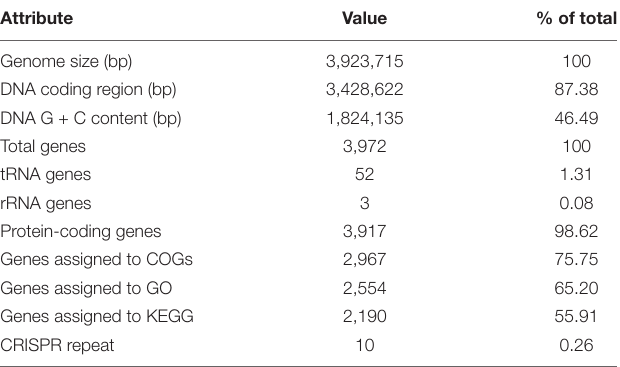
TABLE 2 | Summary of the strain QN1NO-4 genome.